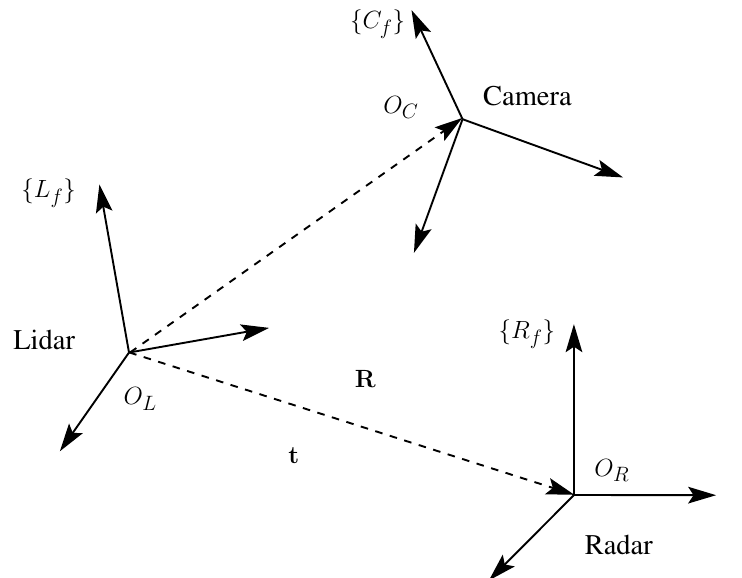
Figure 1. The sensors used on the testbench include: ( a ) a L3CAM sensor consisting of a lidar and an RGB camera on the top and ( b ) a UMRR-96 Type 153 radar sensor at the bottom.